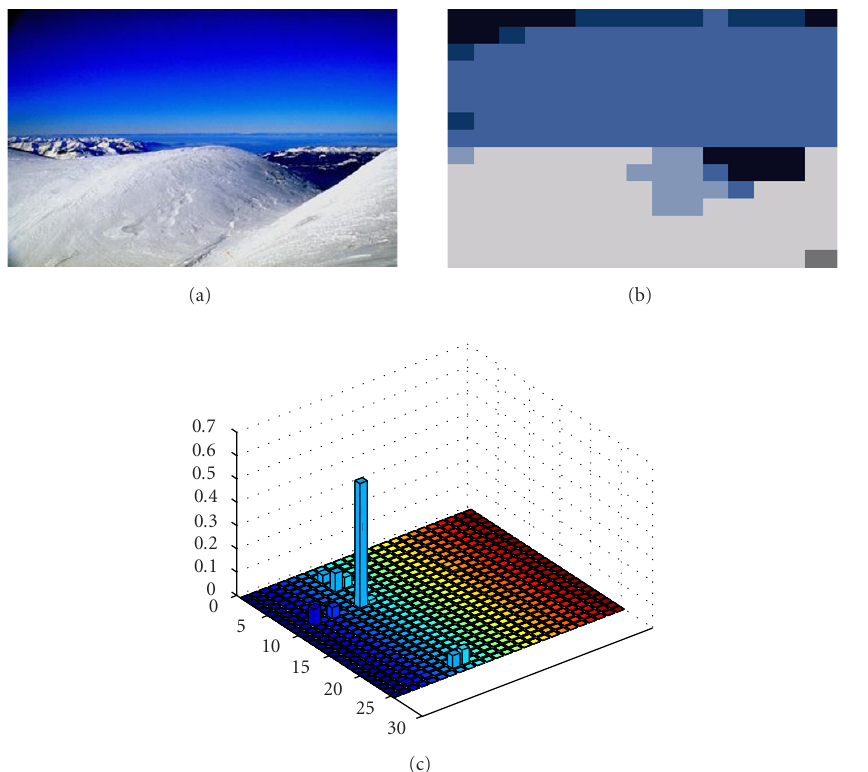
Figure 6: Example of transition matrix with 15 × 15 blocks. (a) Original image. (b) Block-image. (c) 3D representation of colorimetric transition